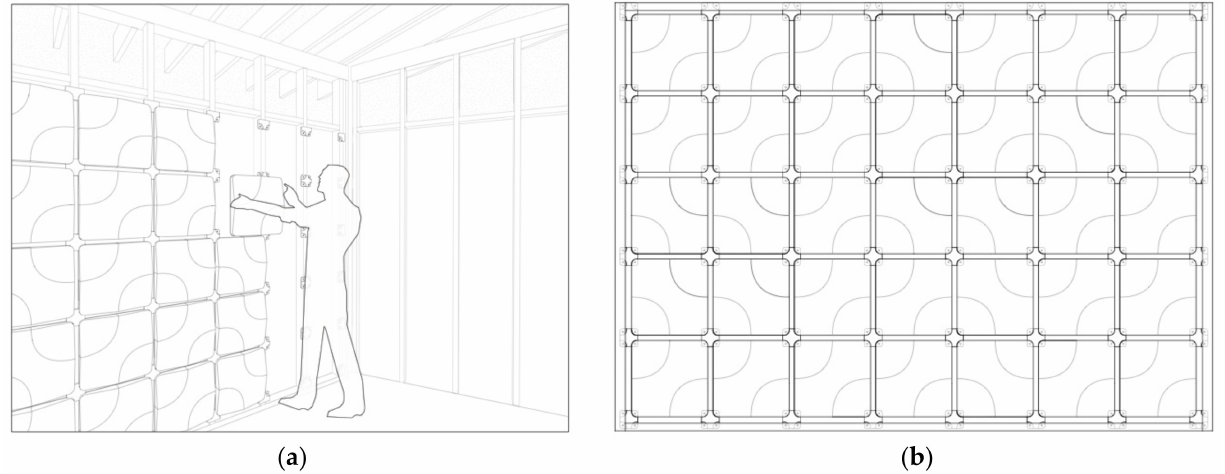
Figure 14. Parametric acoustic panel wall prototype design: ( a ) Acoustic panel installation illustrated ( b ) Example wall